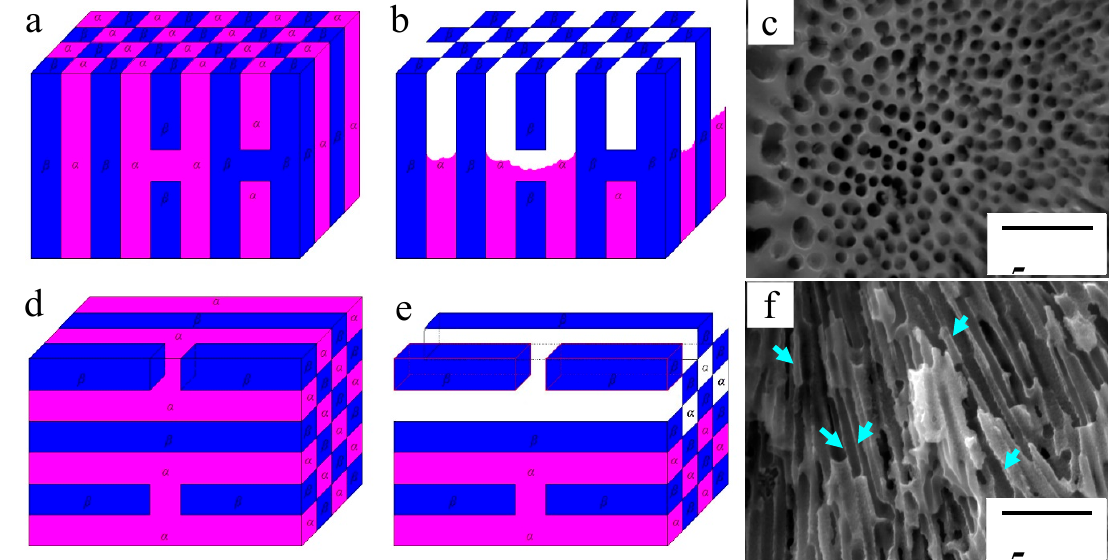
Figure 11. Effect of grain orientation on corrosion mechanism and corrosion morphologies of eutectic microstructures: ( a , b ) Schematic diagrams of the point-like eutectic before and after immersion test; ( c ) corrosion morphologies of the point-like eutectic after 90 min of immersion; ( d , e ) schematic diagrams of the feather-like eutectic before and after immersion test; ( f ) corrosion morphologies of the feather-like eutectic after 90 min of immersion in HAc solution.